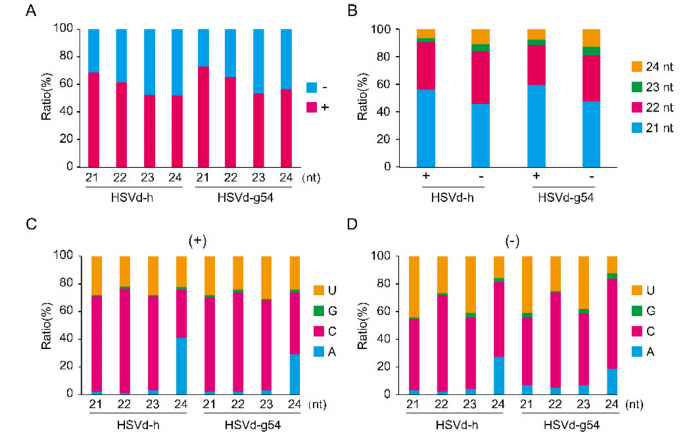
Figure 6. Polarity ( A ), size ( B ), and 5 (cid:48) -terminal nucleotides for genomic ( + )-strand ( C ) and anti-genomic ( − )-strand ( D ) HSVd-derived small RNA (HSVd-sRNA) extracted from cucumber plants infected with HSVd-g54 or HSVd-h at 28